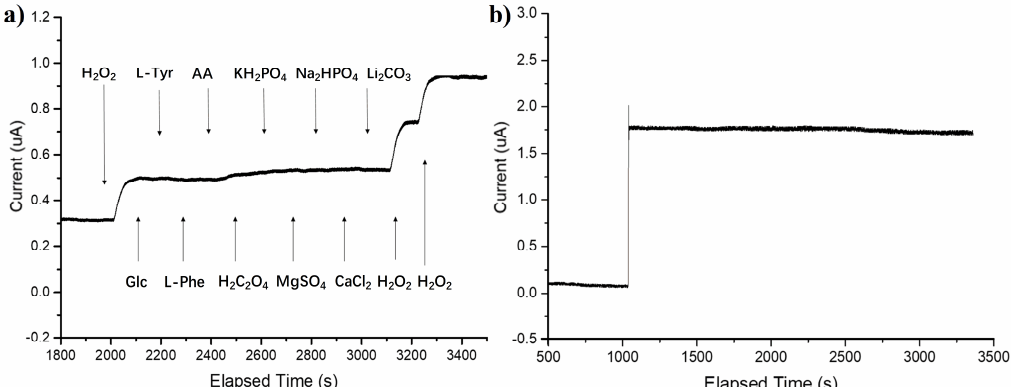
Figure 5. ( a ) Effects of ten interfering species on the response curve of Fe@PCN-224/Nafion/GCE in the presence of H 2 O 2 . Each arrow represents the addition of the corresponding substance at a concentration of 100 µ m. ( b ) The dynamic response curve of Fe@PCN-224/Nafion/GCE towards 400 µ M H 2 O 2 over 2300 consecutive seconds.